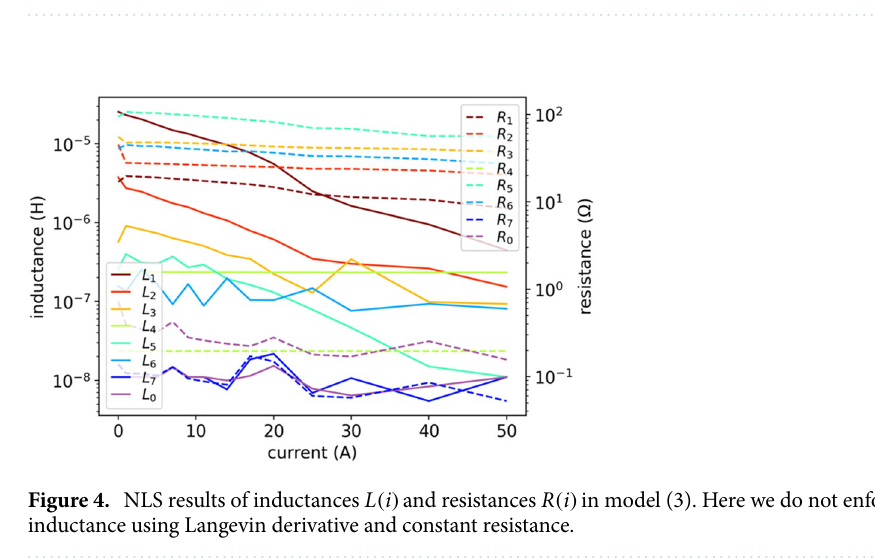
Table 1. fit relative error 1 averaged over all frequencies and currents for different optimization methods. 1 see formula (4), 2 the PSO error is unacceptable. for higher values of currents i ≥ 30 A (see Fig. 7). Best result is in bold.